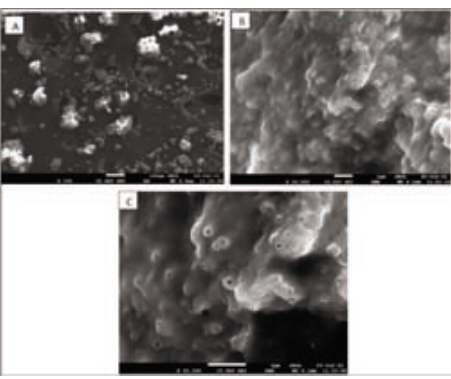
Fig. 4. Absorption spectra for S-AgNPs